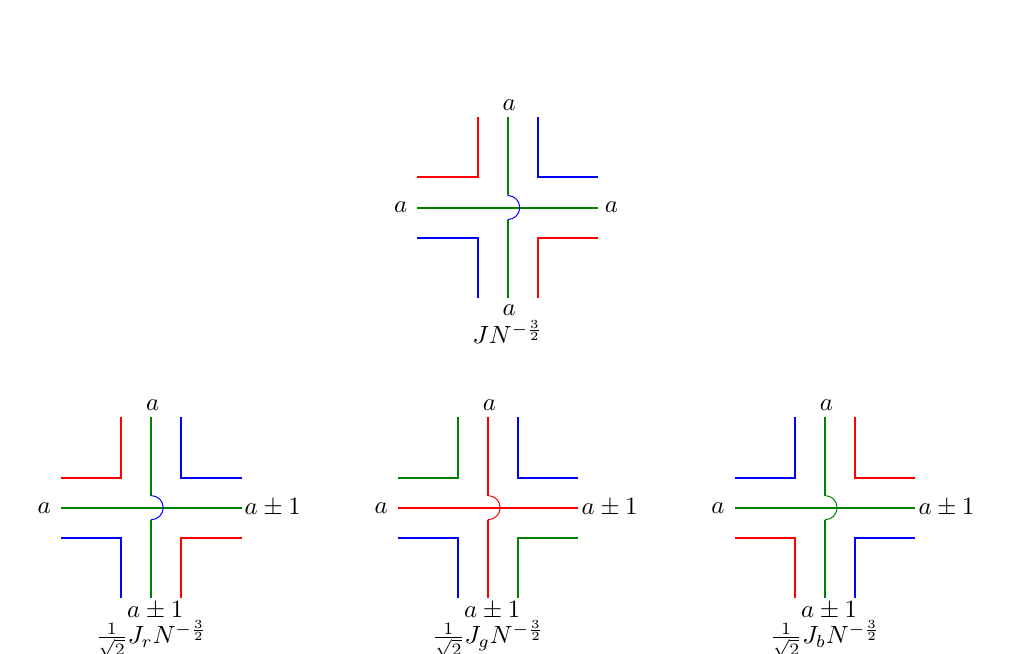
Figure 9. The Vertices of KT chain model on the lattice with the nearest neighbor interaction (GQS interaction).